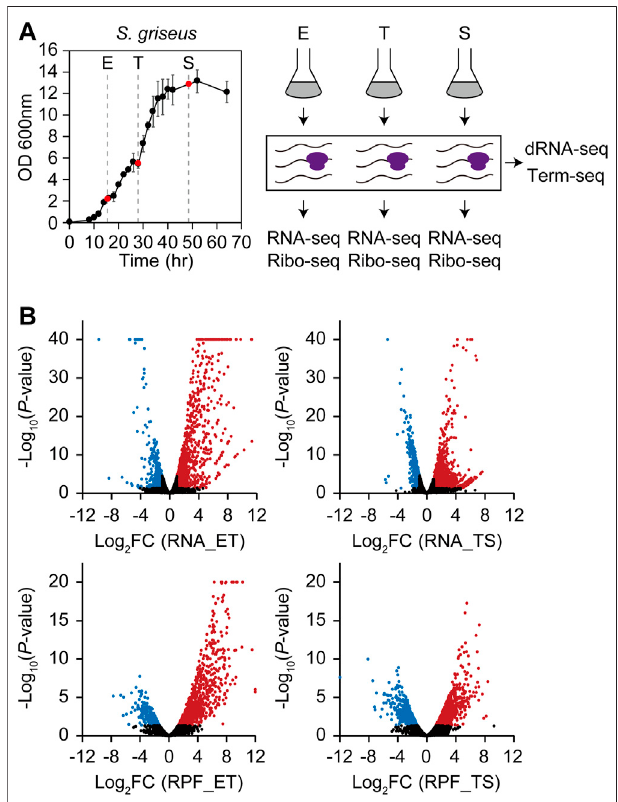
FIGURE 1 | Four types of multi-omics data (RNA-seq, ribosome pro fi ling, dRNA-seq, and Term-seq) of S. griseus in three different growth phases. (A) Growth pro fi les and overall experimental scheme for S. griseus multi-omics data generation. Liquid cell cultures were collected in duplicateatthreegrowthphases,whichare15.5 h(E,early-exponential),28 h (T, transition), and 48.5 h (S, stationary). RNA-seq and ribosome pro fi ling libraries were prepared from each growth phase sample respectively, while dRNA-seq and Term-seq libraries were prepared from the pooled samples of the three growth phases. (B) Overall gene expression pro fi les of RNA-Seq (upper)and ribosome pro fi ling(lower) representedbyfoldchangeand p -value of DESeq2 normalized gene expression from E to T (ET) and T to S (TS). Red dots are upregulated genes (Log 2 FC > 1, p < 0.05), blue dots are downregulated genes (log 2 FC < – 1, p < 0.05), and black dots are the rest of the genes that are not differentially expressed. The dots with